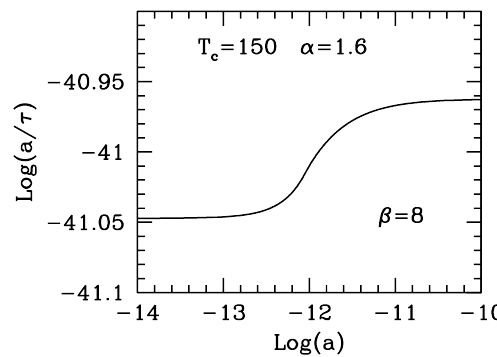
Figure 6. Scale dependence of the a / τ ratio during the QH